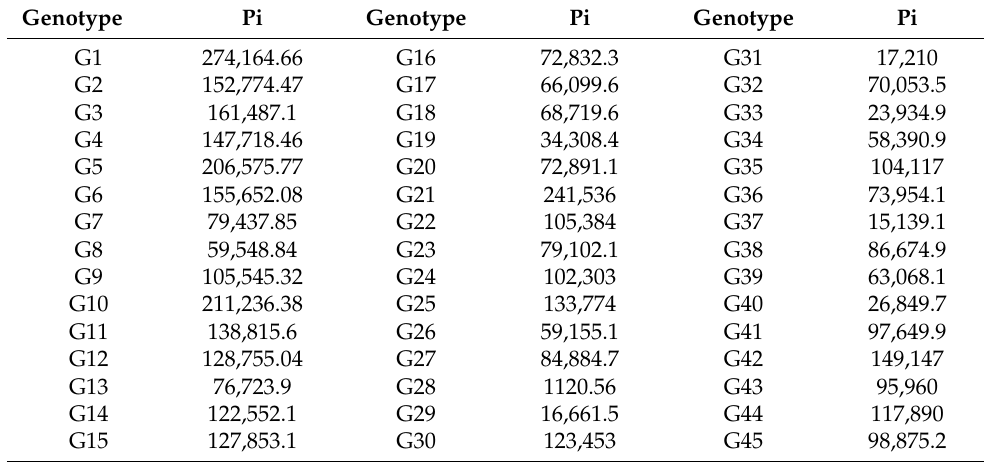
Table 8. Cultivar superiority measure of assessed tepary bean